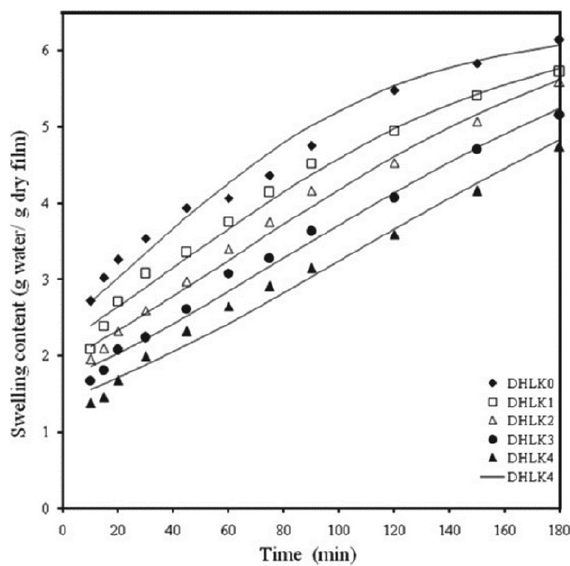
Figure 8. Fitting of the modified Lag phase sigmoid model of films of HPMC K100LVCR matrix with varied kaolin content.